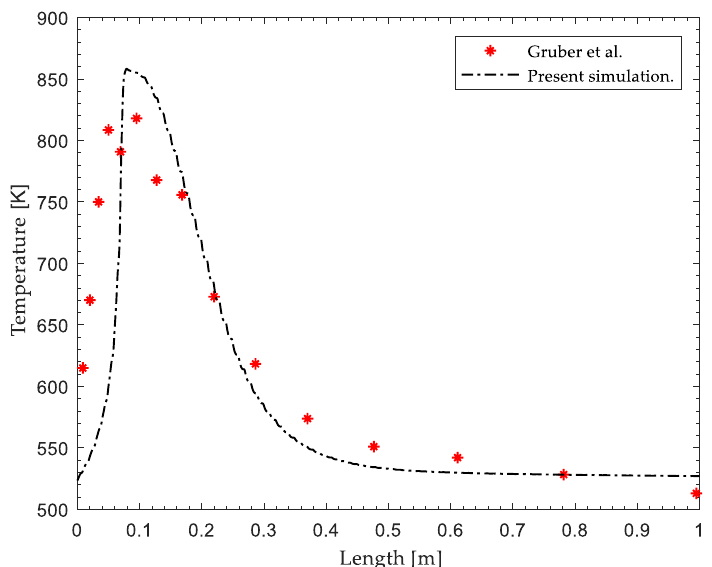
Figure 2. Axial Temperature profile comparison between Experimental data and current 2D vali- dation model.